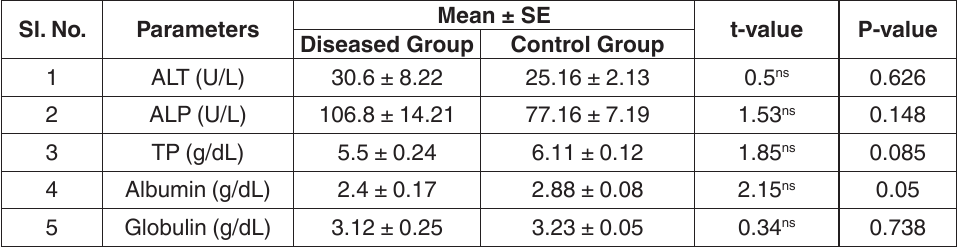
table 2. Comparison of serum biochemical values of dogs with malasseziosis and control animals sl. No.